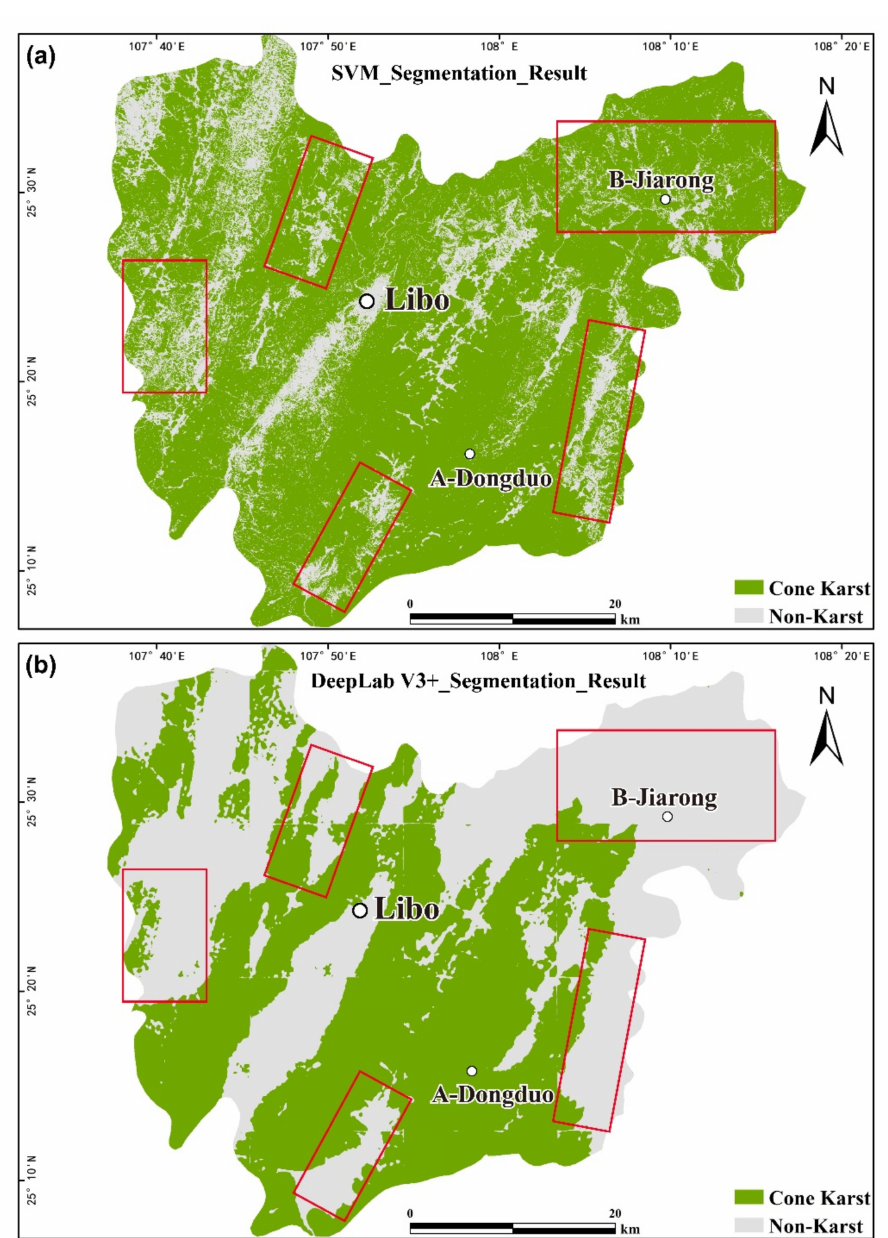
Figure 8. Segmentation results of cone karst in Libo using ( a ) SVM model and ( b ) DeepLab V3+ model.